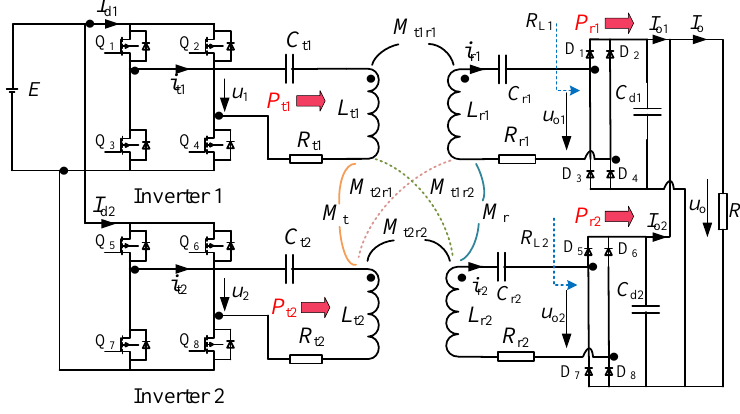
Figure 4. The circuit of proposed WPT system.